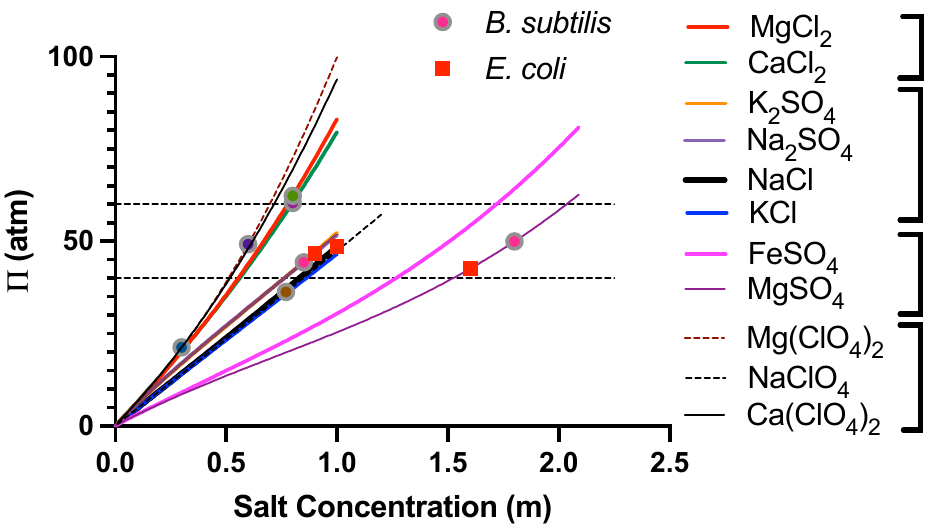
Figure 10. Osmotic pressure, Π , as a function of concentration of aqueous solutions of various salts at T = 37 ◦ C, computed using the Pitzer model. We also show the osmotic pressures corresponding to the limiting salt concentrations of growth of E. coli and B. subtilis